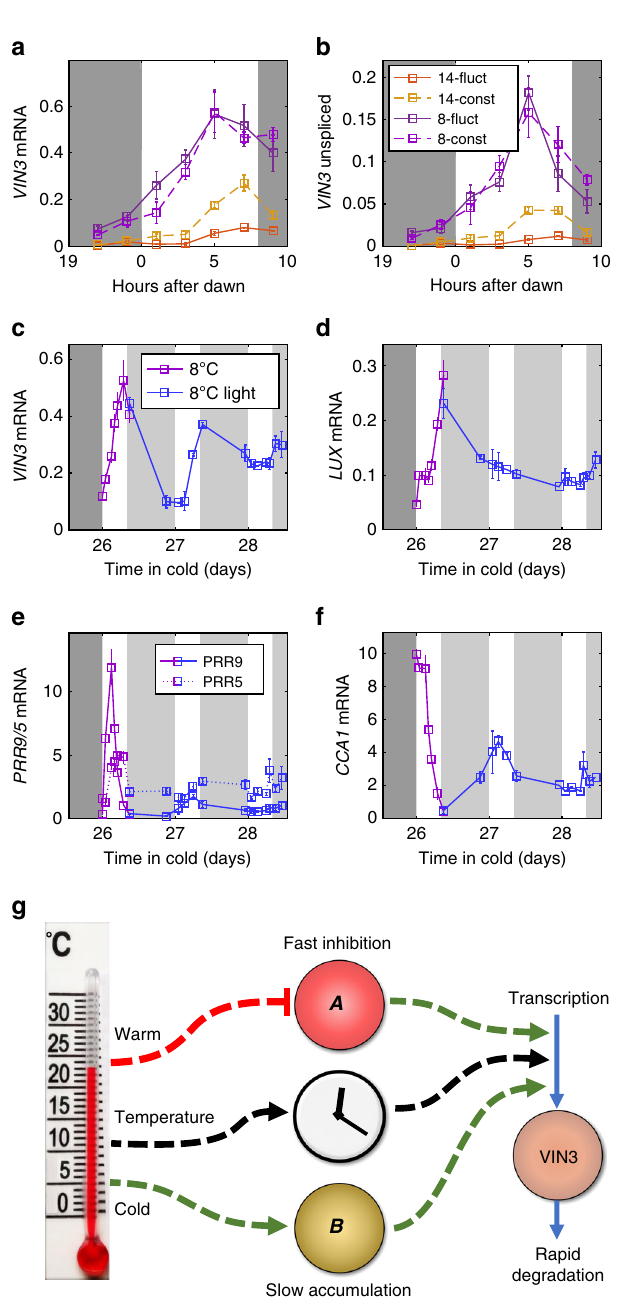
Fig. 4 VIN3 expression is regulated in a circadian manner. a , b VIN3 spliced and unspliced expression over 12 h. Plants grown in 20 °C night, 22 °C day 16 h photoperiod for 1 week and transferred to vernalising 8 h photoperiod with constant or fl uctuating 14.2 or 8 °C pro fi les (as shown in Fig. 2a) for 4 weeks. The dark grey background indicates night-time. Error bars are s.e. m., n = 2 – 3, average > 2.7. c − f , VIN3 and various clock gene mRNA levels sampled on consecutive days at 8 °C after 4 weeks constant 8 °C, 8 h photoperiod (purple). On the fi rst day of sampling the plants were transferred to constant light conditions (blue). The lighter grey background indicates subjective night. RNA levels normalised to UBC , PP2A . n = 1 – 3, average > 2.1. g Summary of VIN3 regulation showing the slow regulator ( B ), the new component ( A ) found to be necessary from modelling which gives the absence of warm regulation and the circadian clock, which could itself also be used as a temperature